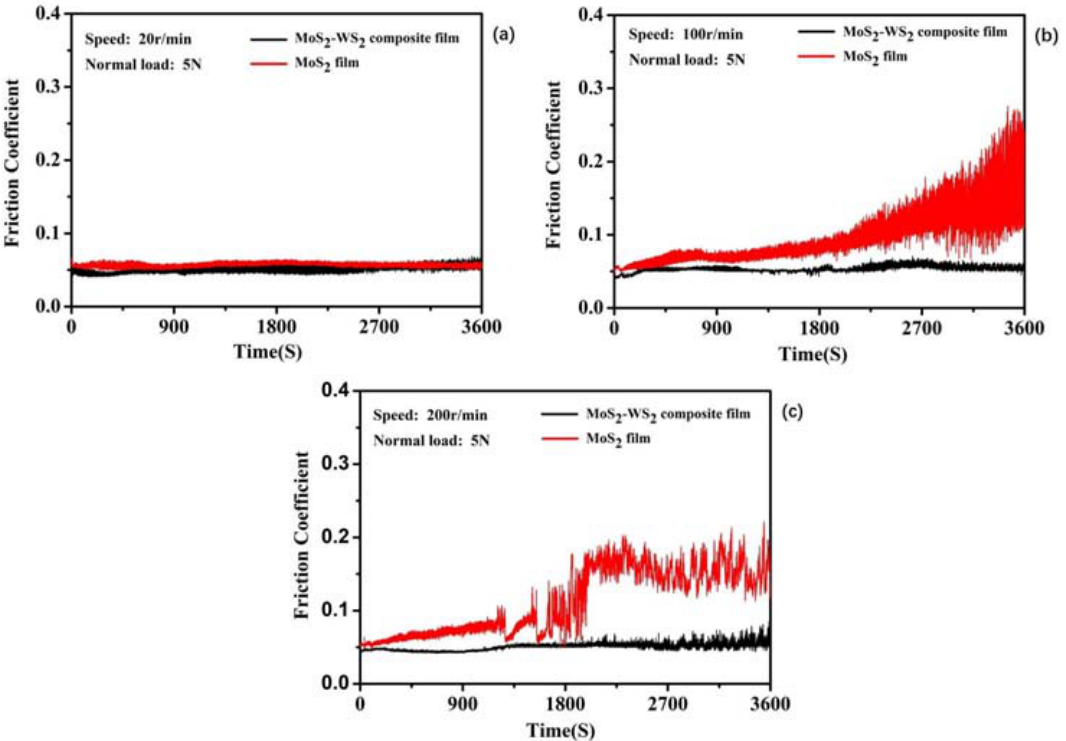
Figure 9. The real ‐ time friction coefficient of pure MoS 2 and MoS 2 –WS 2 composite film at different sliding speed under AO-irradiation condition. ( a ) 20 r / min, 5N, ( b ) 100 r / min, 5N, ( c ) 200 r / min, 5N.